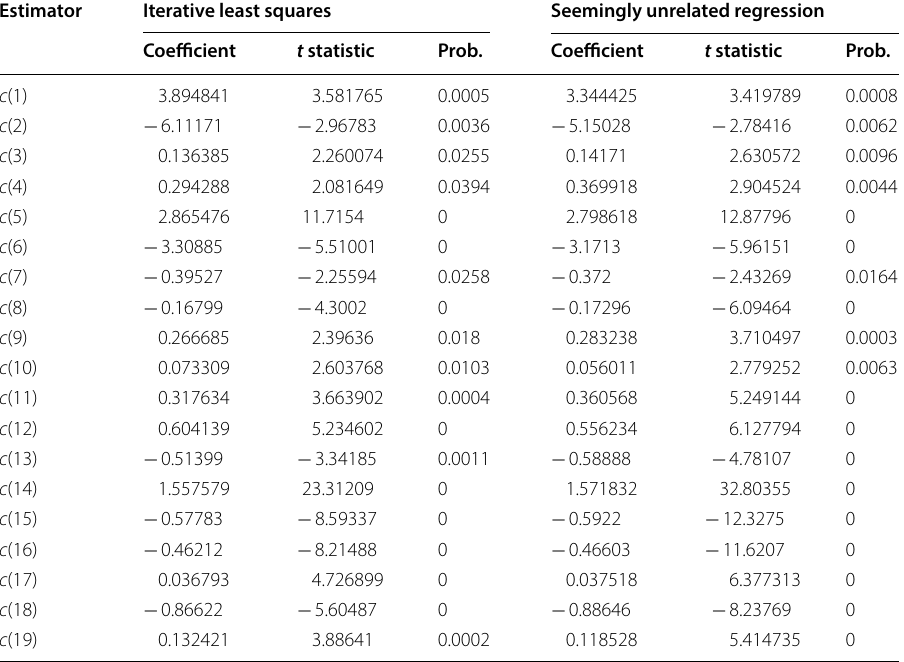
Table 2 Estimations OLS 1- SUR 1